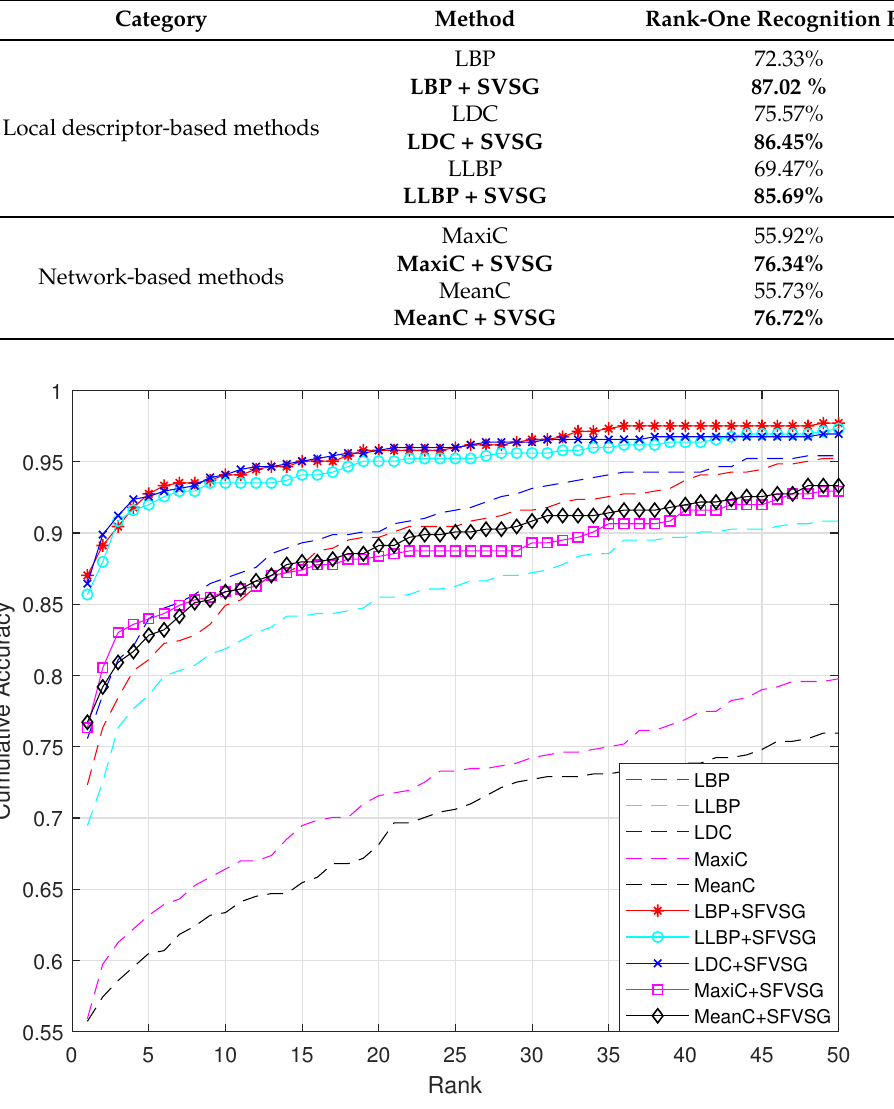
Figure 7. CMCs of different